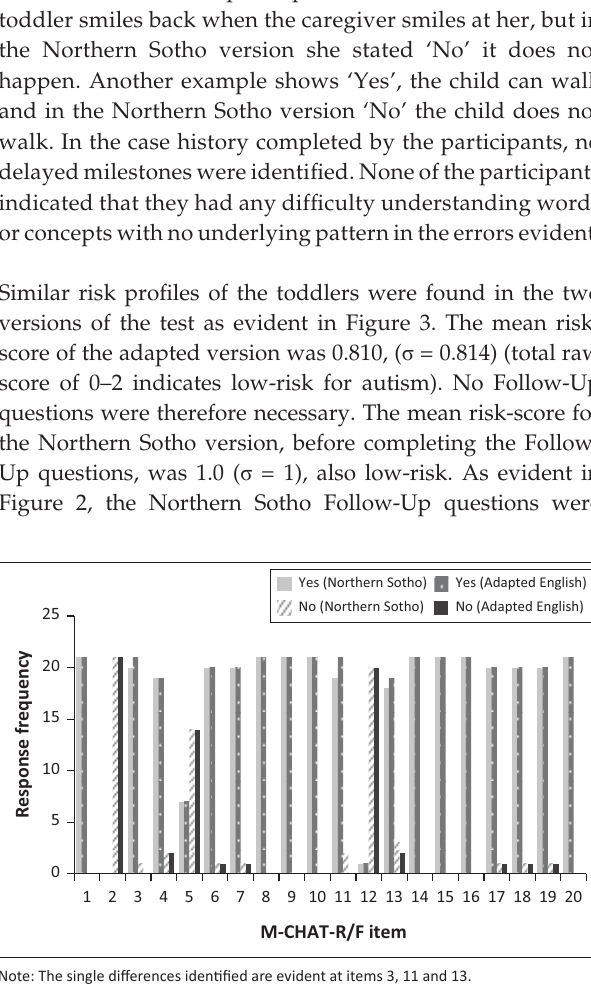
FIGURE 1 : Comparison between Northern Sotho versus adapted English Modified Checklist for Autism in Toddlers, Revised with Follow-Up (M-CHAT-R/F).